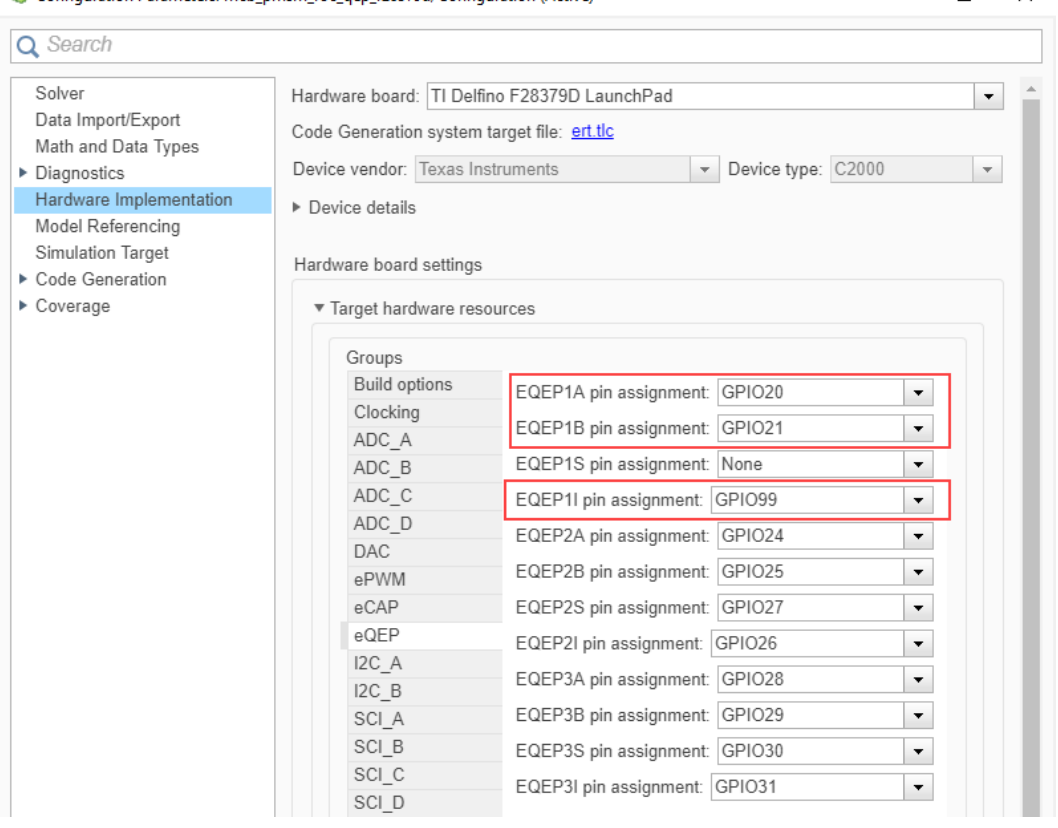
Figure 7. Setup for quadrature encoder connected to LAUNCHXL-F28379D board.